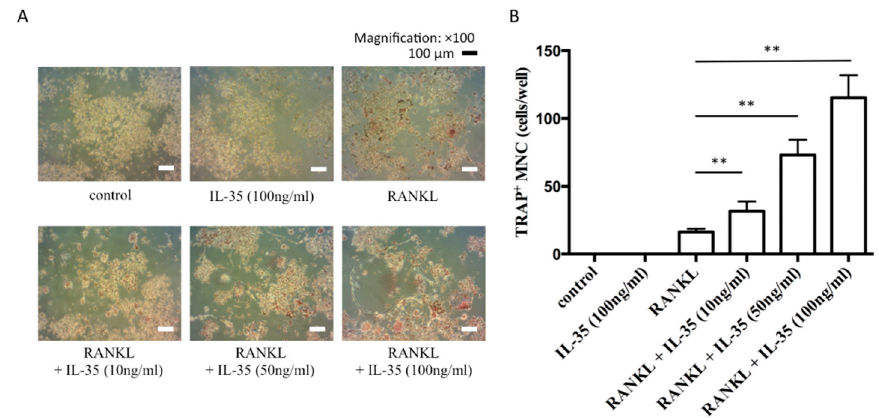
Figure 1. IL-35 synergistically induces receptor activator of nuclear factor- κ B ligand (RANKL)-dependent osteoclast formation. ( A ) RAW264 (RAW) cells stimulated with 50 ng/mL RANKL with or without 10, 50, or 100 ng/mL interleukin (IL)-35 or 100 ng/mL IL-35 alone for 5 days. Bar, 100 µm. ( B ) Tartrate-resistant acid phosphate (TRAP)-positive multinucleated cells were counted as osteoclasts. Differences among groups were analyzed by two-way ANOVA. Data represent the mean ± SD ( n = 3) ** p < 0.01 vs. RANKL alone.